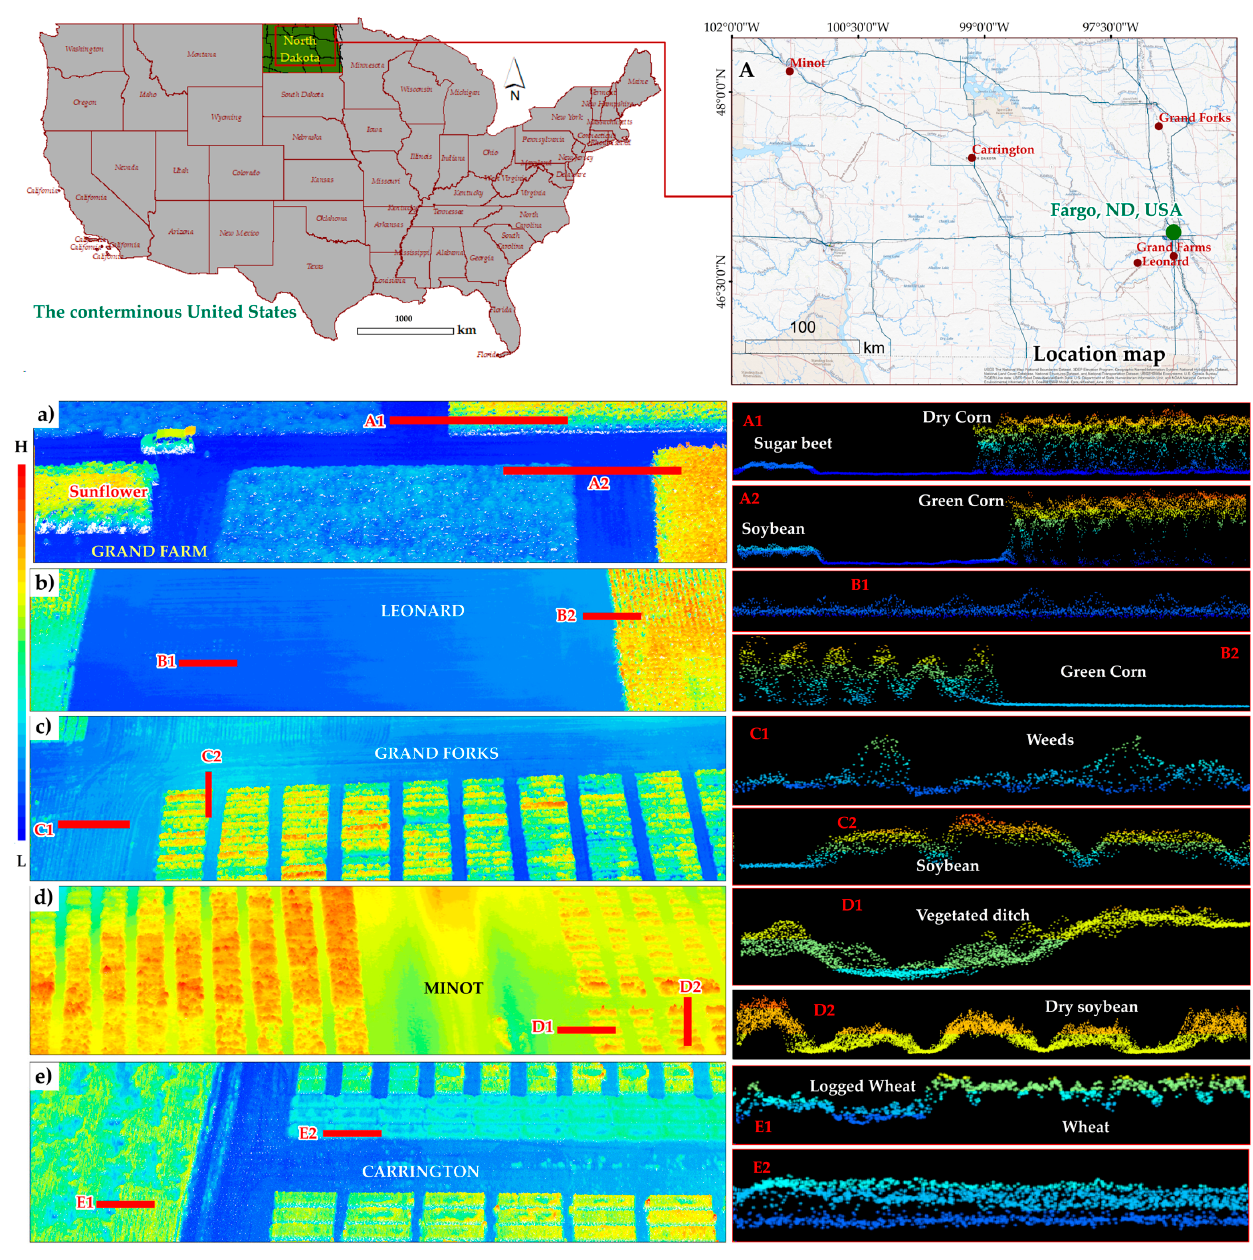
Figure 2. The study site’s locations are in North Dakota (ND), USA (see site location map, top left): ( A ) zoom in view of representative sites in Fargo, ND, USA. ( a ) Grand Farms training site A. ( b ) Leonard, ( c ) Grand Forks, ( d ) Minot, and ( e ) Carrington are the test sites B, C, D, and E (Table 2). ( A1 – E2 ) are some characteristics3D-transects of UAS-LiDAR point clouds. Three-dimensional tran- sects of ( a – e ) are of the same extent (horizontal) for visualization purposes with no vertical scale.